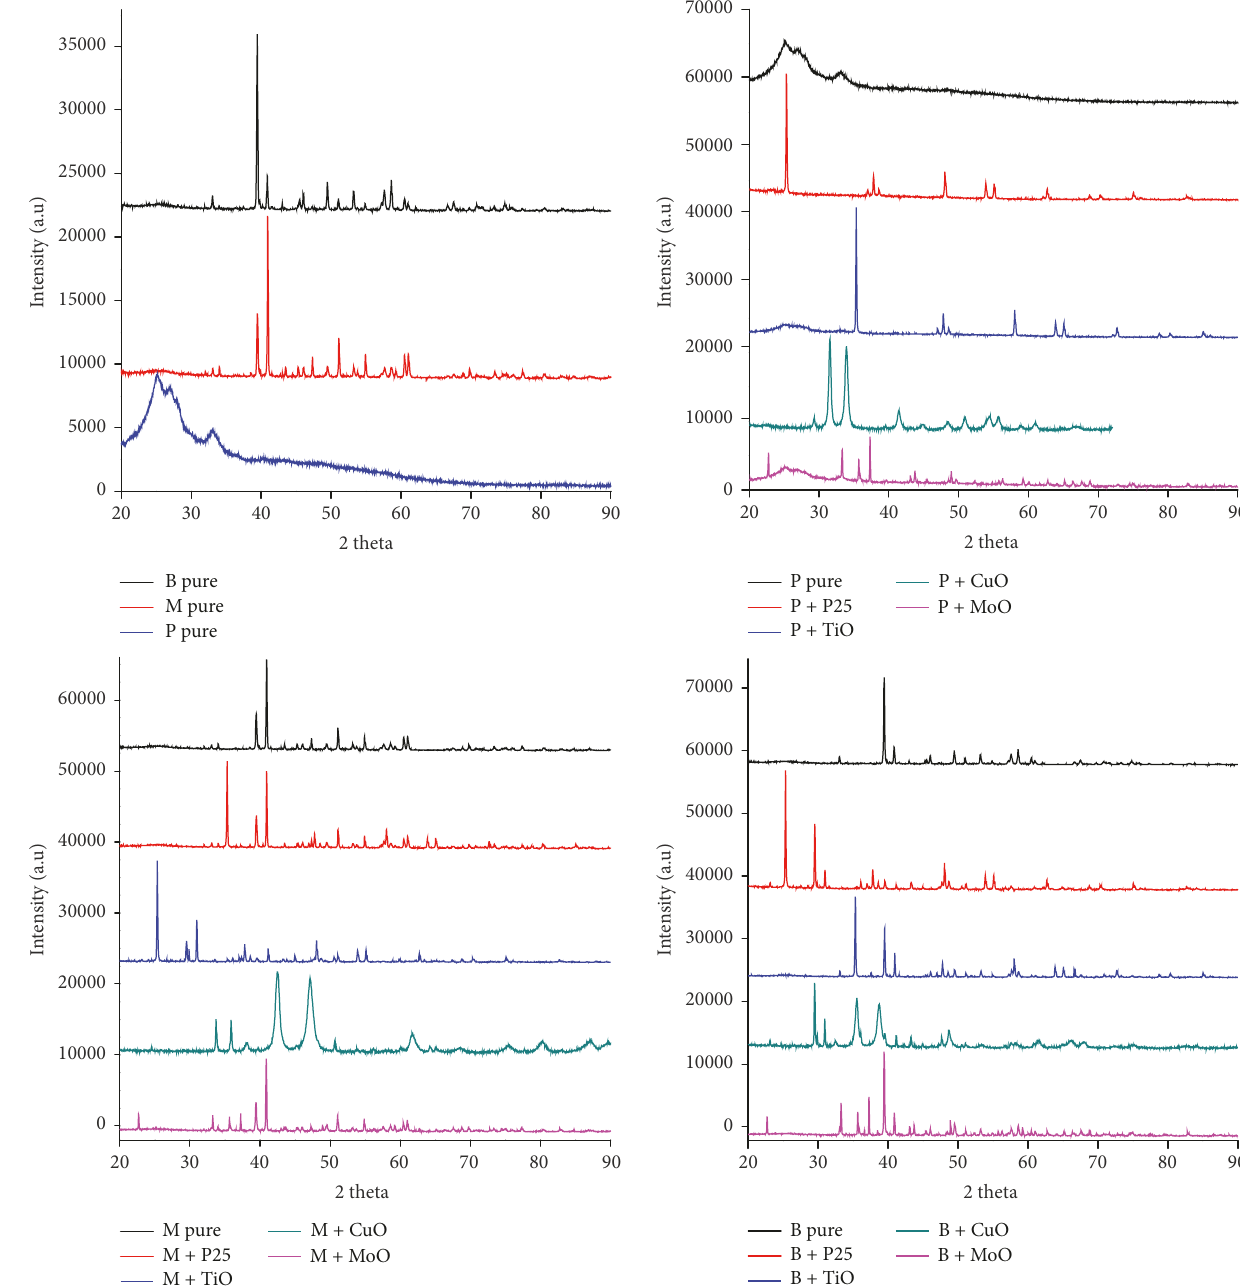
Figure 3: X-ray diffractograms of samples in pure state and also doped with metal oxides nanoparticles.